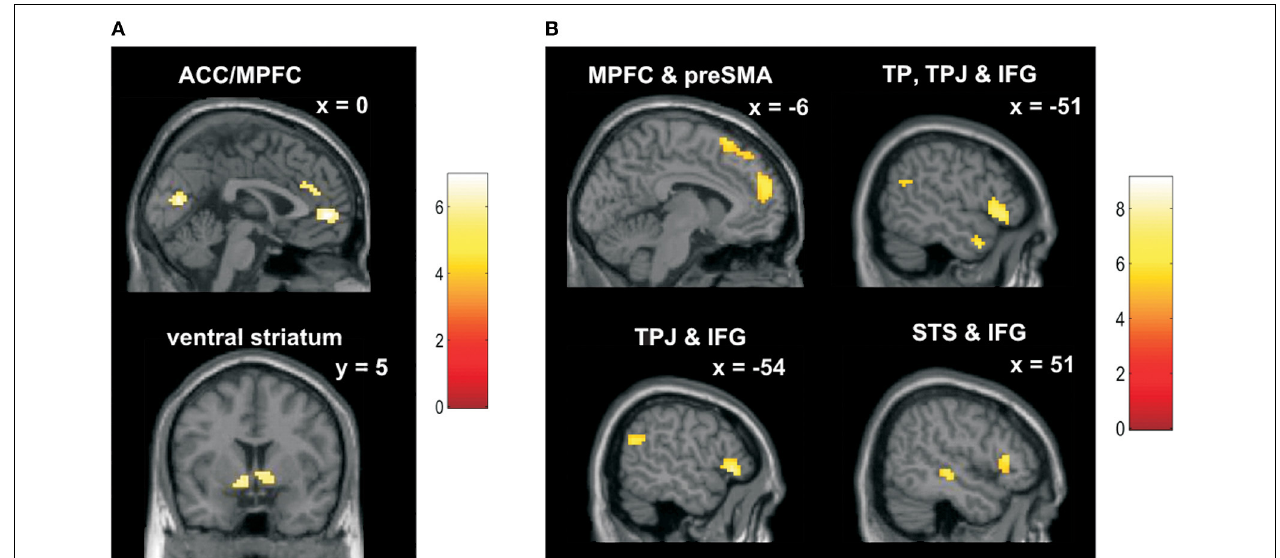
FIGURE 4 | fMRI results—BOLD signals of reward and comparison-related components of social feedback. (A) Across all participants BOLD signal changes in ACC/MPFC and bilateral ventral striatum correlated with the reward-related component of feedback on a trial-by-trial basis at the time-point of feedback ( p < 0 . 05 FWE corrected, cluster size > 15). See Table 4 for a full list of activations. Reward-related activity was identified in a contrast between the parametric modulators for feedback ratings for self and other. Thus, reward-related activity correlated positively with feedback ratings for self (e.g., a feedback rating of 8.0 on “polite” is more rewarding than a feedback rating of 7.0; feedback ratings for negative